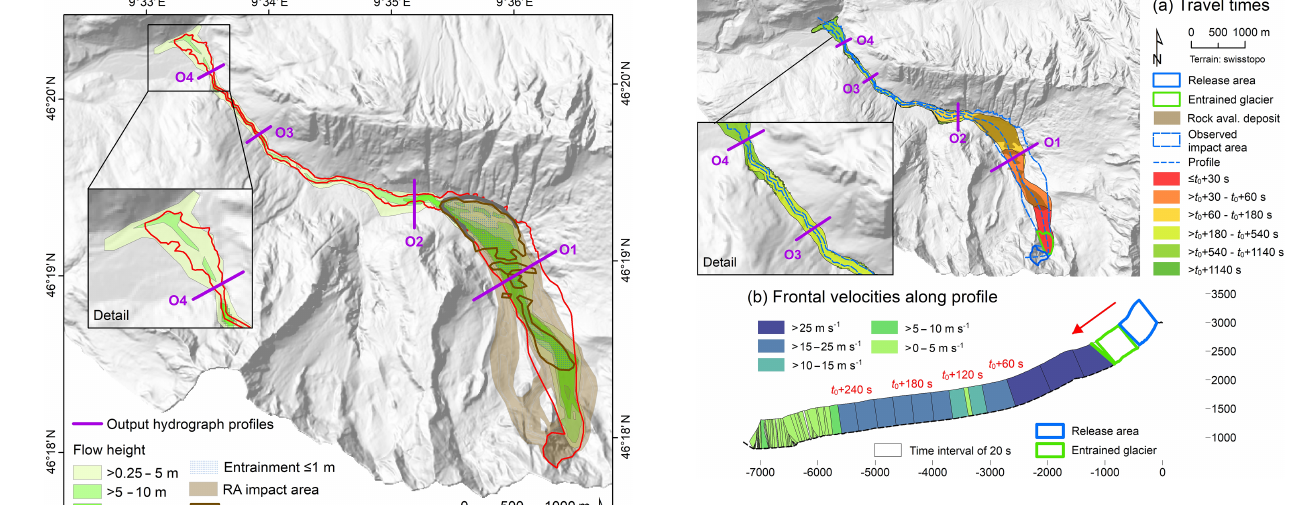
Figure 12. Spatio-temporal evolution and velocities of the event ob- tained for Scenario S2. (a) Travel times, starting from the release of the initial rockslide–rockfall. Therefore t 0 (s) is the time between the release of the rockslide–rockfall and the mobilization of the en- trained glacier. (b) Frontal velocities along the flow path, shown in steps of 20s. Note that the height of the velocity graph does not scale with flow height. White areas indicate that there is no clear flow